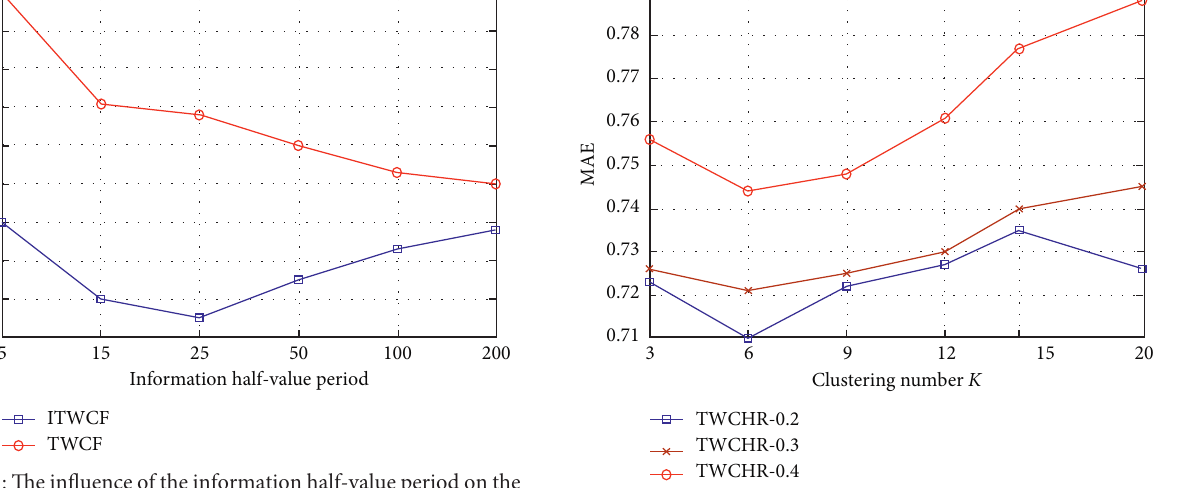
Figure 3: The influence of the clustering number on the recom- mendation algorithm.